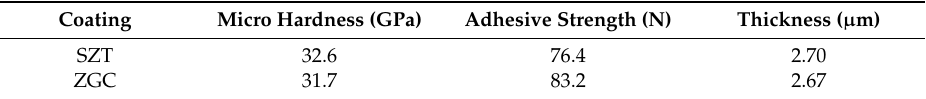
Table 2. Mechanical properties of the coatings.